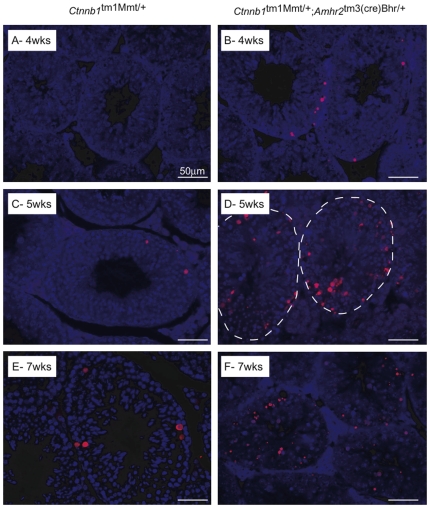
Increased germ cell apoptosis in Ctnnb1
tm1Mmt/+;Amhr2
tm3(cre)Bhr/+ testis.(A–F) TUNEL staining (red) in Ctnnb1
tm1Mmt/+;Amhr2
tm3(cre)Bhr/+ testes (B, D, F) compared with Ctnnb1tm1Mmt/+ controls (A, C, E) at different ages. Counterstain = DAPI (blue). For clarity, seminiferous tubules are circumscribed with a dotted white line in panel D.